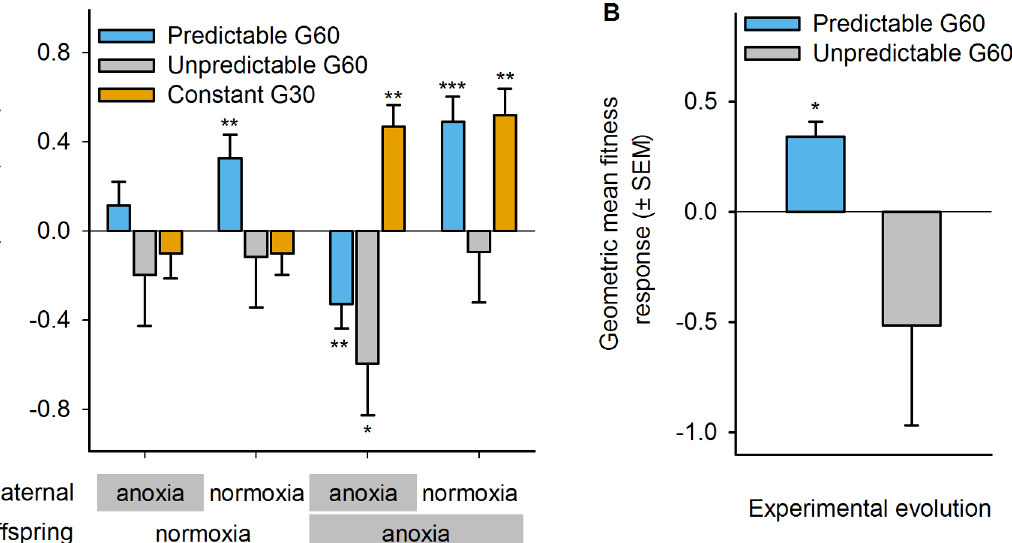
Fig 4. Adaptation to normoxia – anoxia environments. (A) Relative fitness of predictable (blue), unpredictable (grey), and constant (orange) populations to the ancestor population (zero line), across the four combinations of maternal – offspring environments. Ancestor and evolved populations were concurrently assayed after two generations of “ common garden ” maintenance to account for thawing assay block effects (see Materials and Methods). Relative fitness is calculated as the natural logarithm of evolved growth rates over the mean ancestral growth rate per block. Mean and error least square estimates are shown after separate LMM for each experimental regime, taking replicate population as a random factor and the maternal – offspring hatching treatment as a fixed factor. Significant fitness responses relative to the ancestor population (done with post-hoc Student t tests, with LMM-corrected KR degrees of freedom) are shown above each bar: * p < 0.05; ** p < 0.01; *** p < 0.001. (B) From (A), the geometric mean fitness is calculated over anoxia – normoxia and normoxia – anoxia absolute fitness separately for each of the four replicate predictable populations, or over all mother – offspring environments for each of eight unpredictable populations, and compared to the absolute fitness of the ancestral population. Error bars show one standard error of the mean among replicate populations. Significance of a Student t test is shown above the bar: * p < 0.05. Data deposited in the Dryad repository: http://dx.doi.org/10.5061/dryad.56bb4